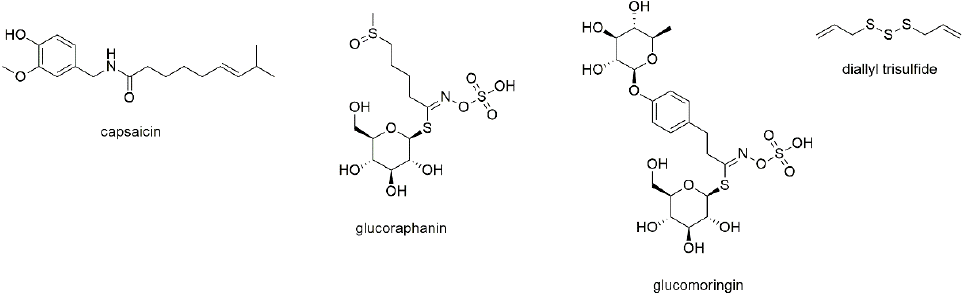
Figure 2. Heteroaliphatic compounds with reported activity against myeloma cell lines.